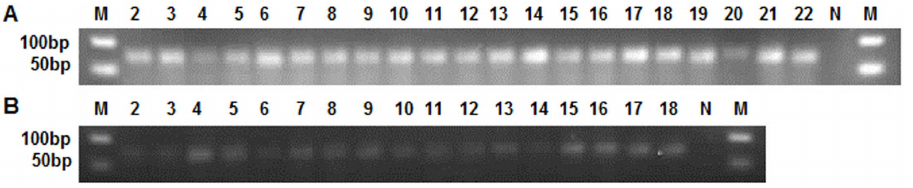
Figure 3. TA-cloning analysis of 33 new miRNAs that have complementary miRNAs* or that had . 100 reads. (A) Lanes 2–6 are the positive controls, known rice miRNAs osa-miR156d, osa-miR166c, osa-miR167d, osa-miR168a, and osa-miR172a. Lanes 7–22; osu-miR1, osu-miR10, osu-miR105, osu-miR123, osu-miR131, osu-miR147, osu-miR150, osu-miR174, osu-miR18, osu-miR180, osu-miR216, osu-miR223, osu-miR238, osu- miR253, osu-miR260, and osu-miR266. (B) Lanes 2–18 are osu-miR284, osu-miR287, osu-miR35, osu-miR4, osu-miR47, osu-miR51, osu-miR6, osu- miR61, osu-miR62, osu-miR64, osu-miR68, osu-miR73, osu-miR75, osu-miR86, osu-miR88, osu-miR96, and osu-miR99. N; negative control; M; 50 bp DNA Ladder size marker.